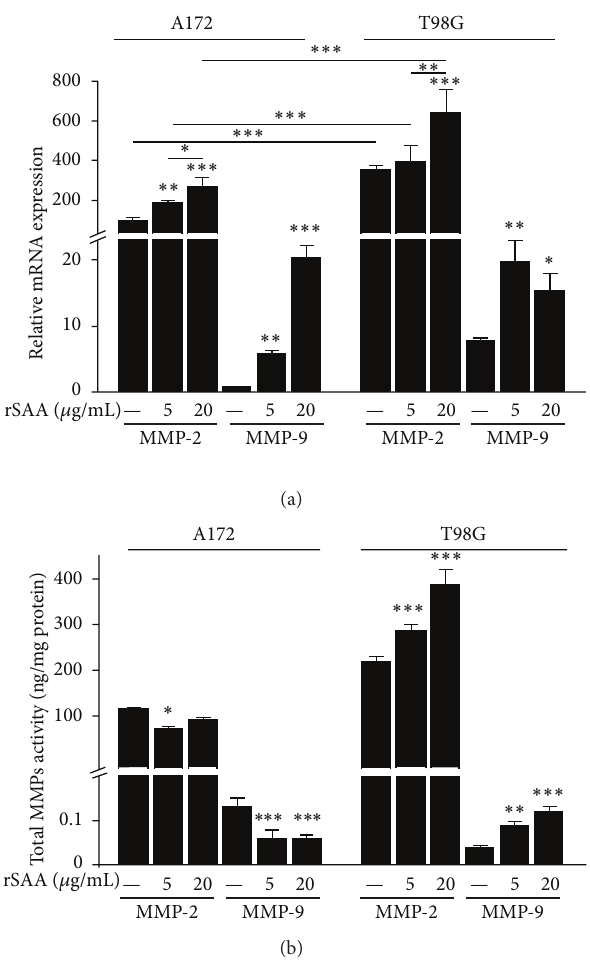
Figure 4: rSAA affects mRNA expression and gelatinolytic activity of MMP-2 and -9 in A172 and T98G cells. (a) Quantitative real-time PCR was performed to assess the mRNA expression of MMP-2 and - 9 on gliomas when stimulated with rSAA (5 and 20 𝜇 g/mL) for 48 h. The mRNA expression of MMP-2 and MMP-9 is increased by rSAA treatment in both gliomas. (b) Enzymatic activity of MMPs was measured in cellular supernatant. Activity data showed a decrease in MMP-2 and MMP-9 activity in A172 cell line, and an increase in MMP-2 and MMP-9 activity in T98G cell line. Data represent mean ± SEM of three experiments. ∗ 𝑃 < 0.05 , ∗∗ 𝑃 < 0.01 , and ∗∗∗ 𝑃 < 0.001 versus